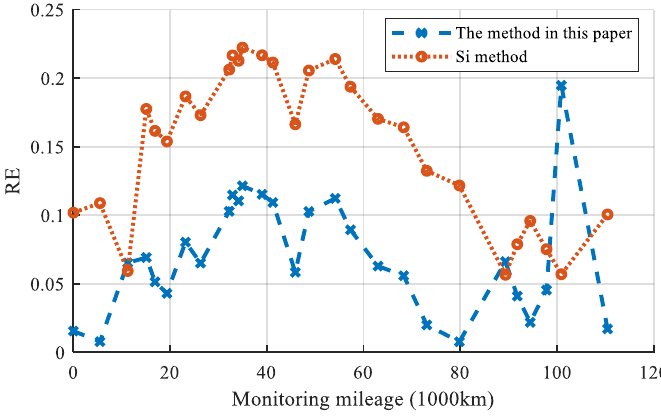
Figure 20. RE of the two methods.